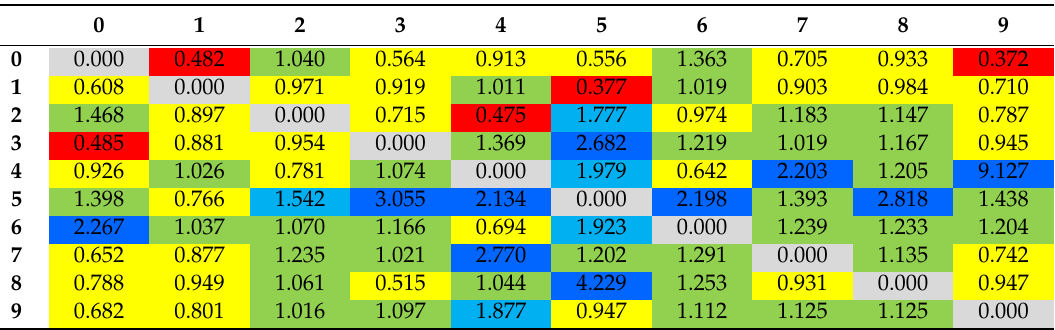
Table 3. The collection of separability ratios ( Ξ m / n ) for the output data in κ 1 , κ 2 , κ 3 projection at the threshold Θ = 0.7. The e ffi ciency of data separation is color coded from red—significantly decreased separability ( Ξ < 0.5), through yellow—slightly decreased separability (0.5 < Ξ < 1),